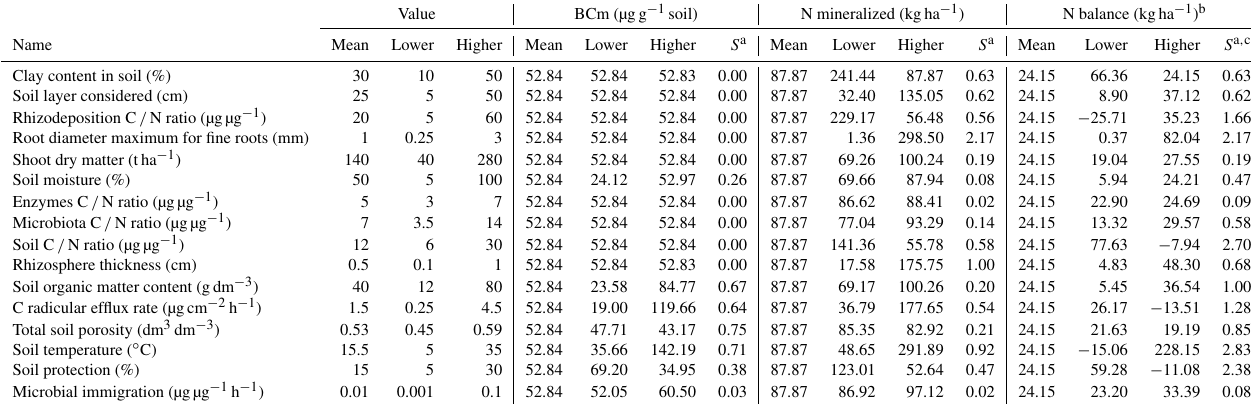
Table 2. Values of the input variables used in the model in relation to estimates of fine-root length, rhizosphere volume, and C rhizodeposition.